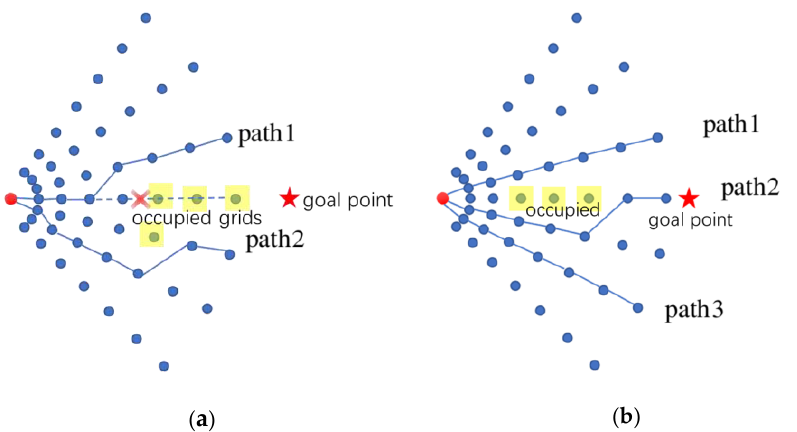
Figure 9. Illustration of path planning when ( a ) target is occupied; ( b ) target is collision-free. The specific path generation procedures are given in Algorithm 1. Algorithm 1 Collision-free path planning